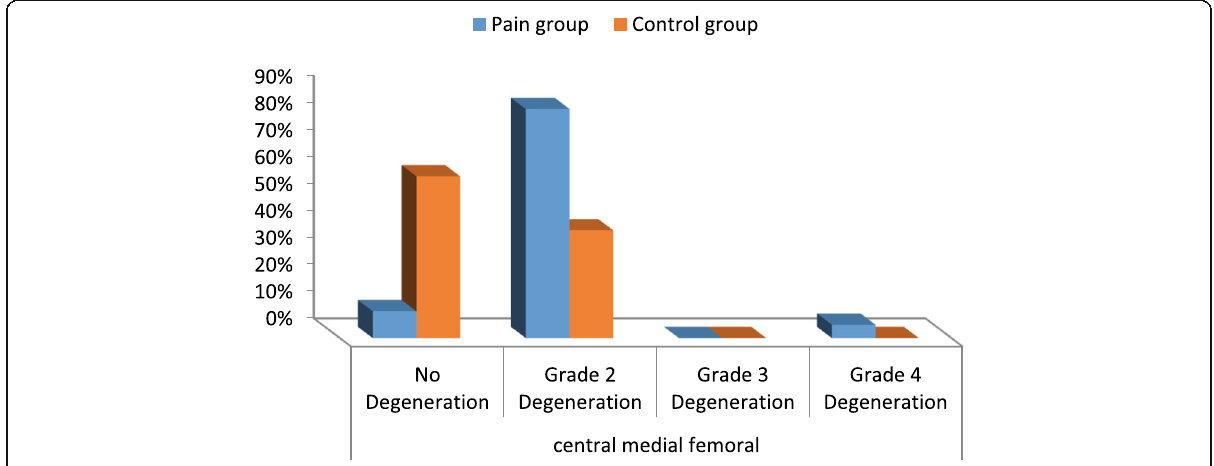
Fig. 6 Distribution of central medial femoral degeneration according to ICRS degeneration